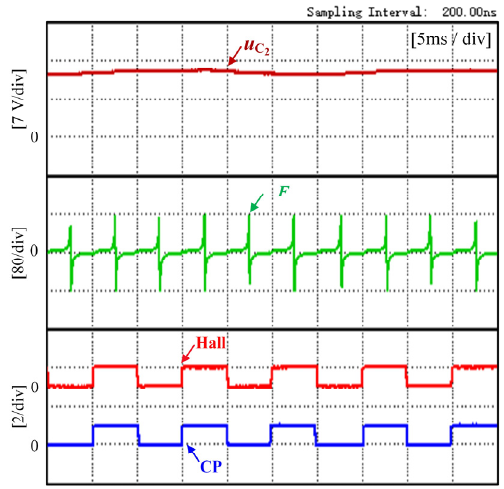
Figure 14. Experimental waveform under the condition of 500 r/min speed and 0.1 N·m torque.